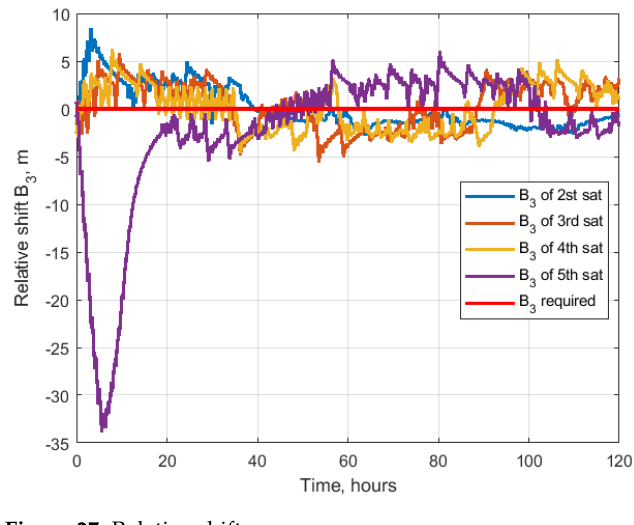
Figure 26. Relative drift.